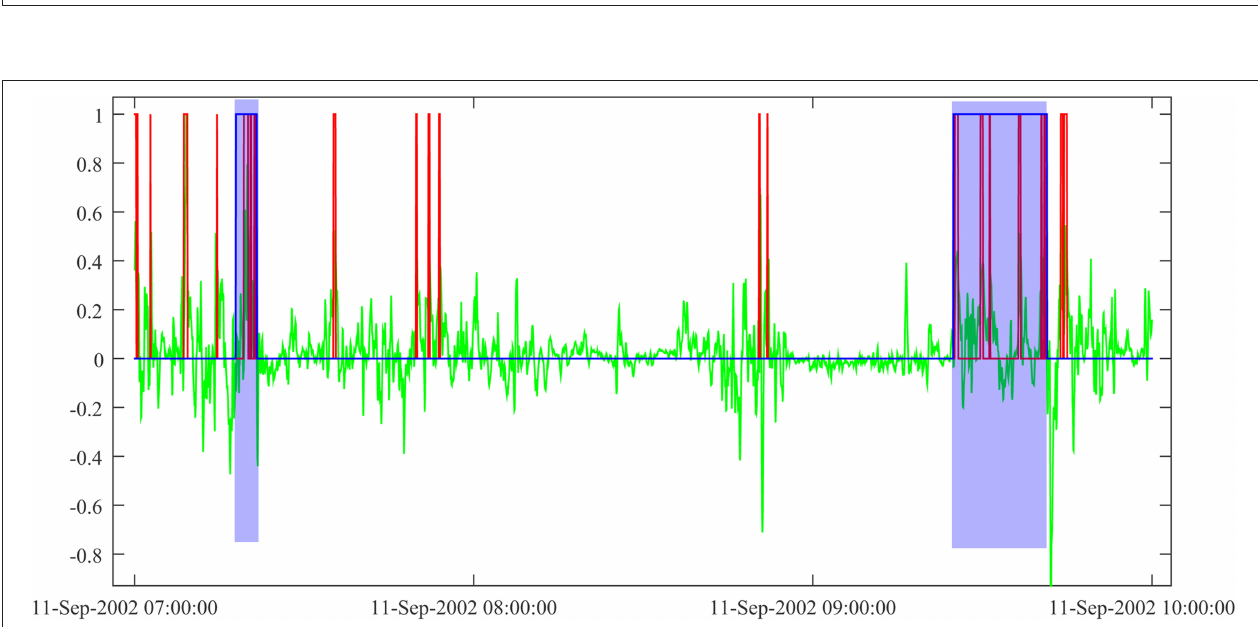
FIGURE 3 | NN output on E · J data: NN output (rounded) in red, E · J in green (normalized to the maximum value of the time interval, here 17.4 pW/m 3 ). Events found by the algorithmic approach are shaded in blue.